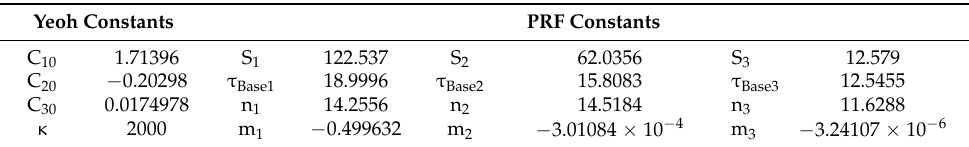
Table 2. Yeoh and PRF constants for